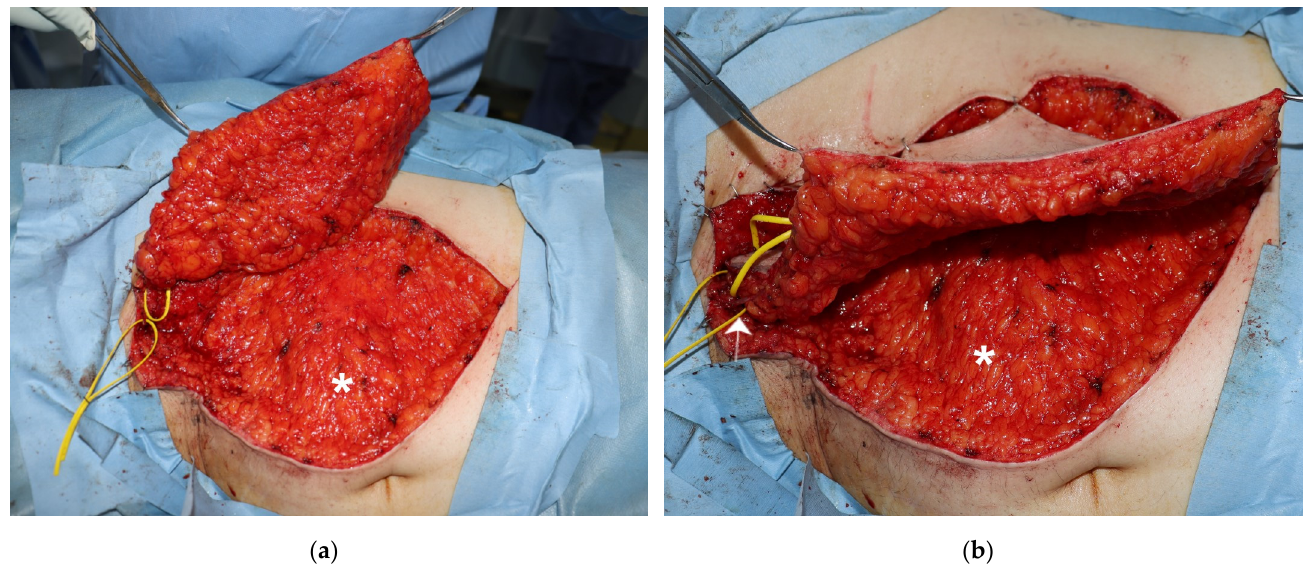
Figure 1. Deep Fat Saving technique. ( a ) The deep fat (*) was saved in an SCIP flap elevation; ( b ) a relatively thick skin flap was harvested based on the superficial branch of the SCIA (white